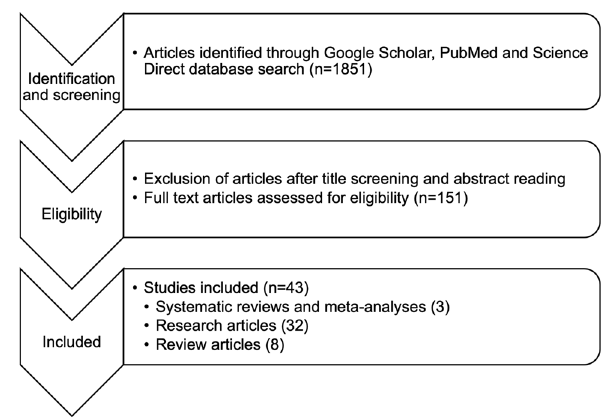
Fig. 1 Schematic representa- tion of selection of articles for the